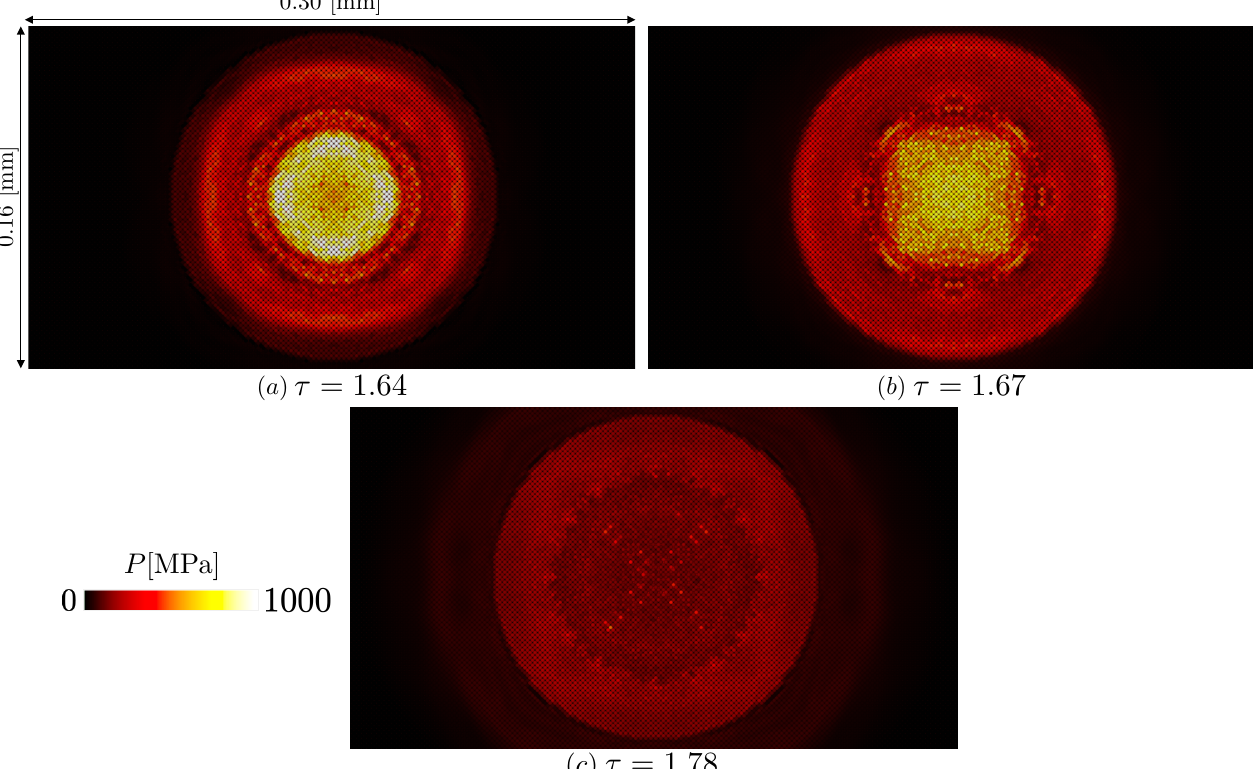
Figure 7. Pressure field over the surface for different collapse snapshots in Region III ( dL / R 0 = 133, γ = 0.6 & P ∞ = 50 [MPa]): ( a ) Pressure field on the surface at the inner shock generation. ( b ) Pressure field of the surface at the second pressure peak. ( c ) Pressure field of the surface during the ring